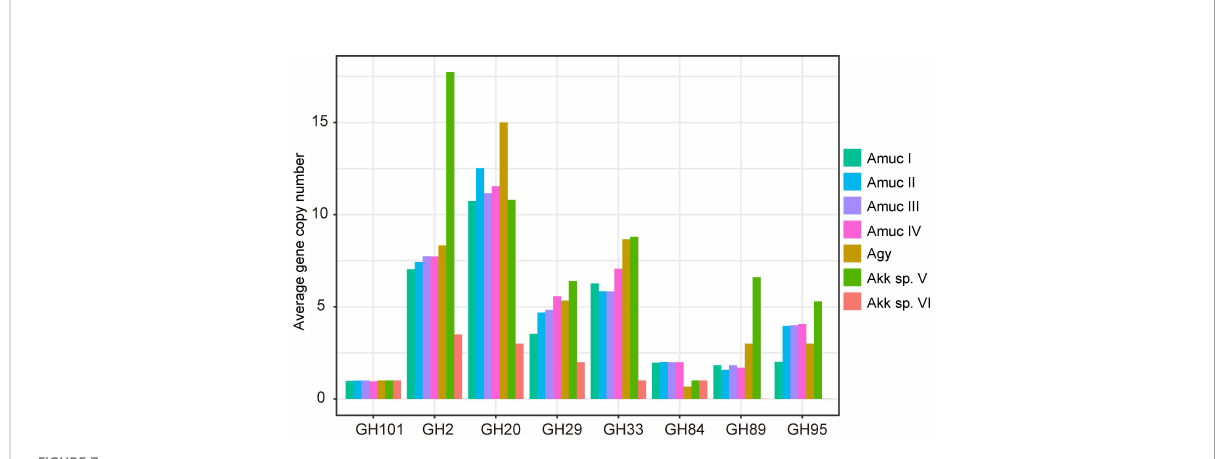
FIGURE 7 Average number of gene copies in each phylogroup of the eight mucin-degrading GH